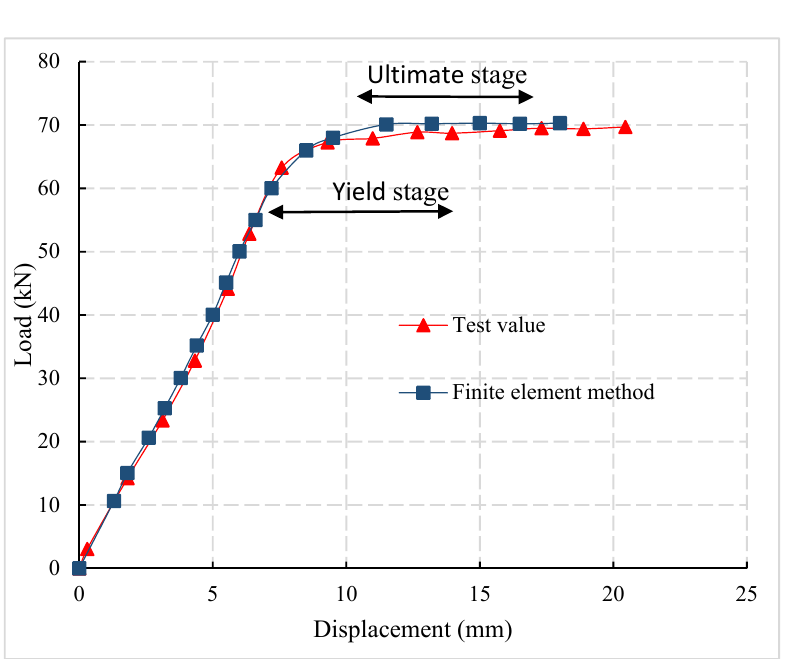
Figure 8. Test finite element